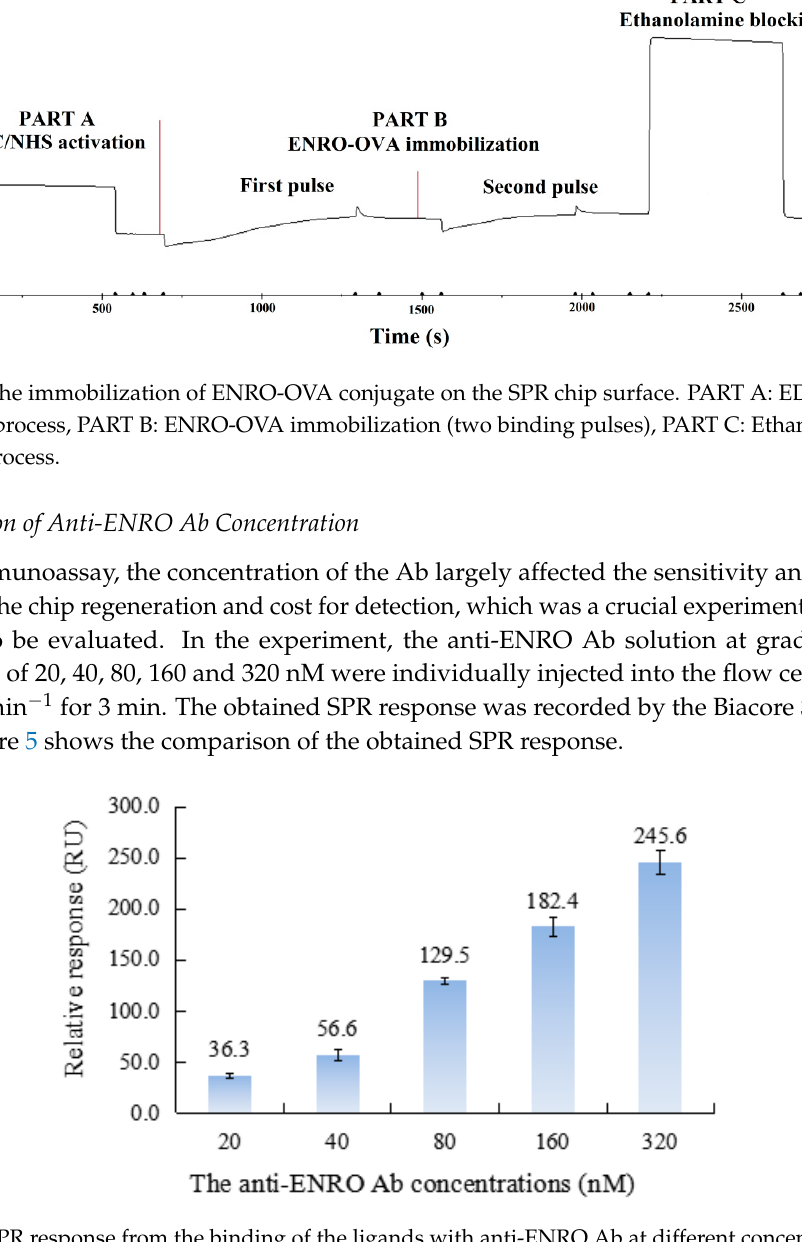
Figure 5. SPR response from the binding of the ligands with anti-ENRO Ab at different concentrations.